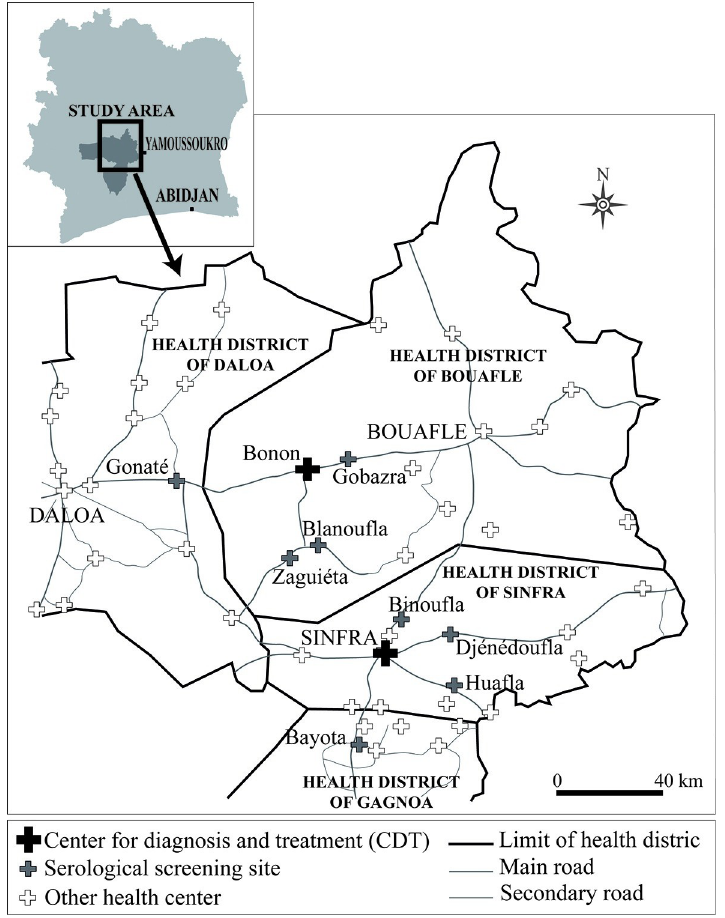
Fig 1. Map showing the localisation of the passive surveillance sites implemented in the Bonon and Sinfra HAT endemic foci in Coˆte d’Ivoire in 2017.